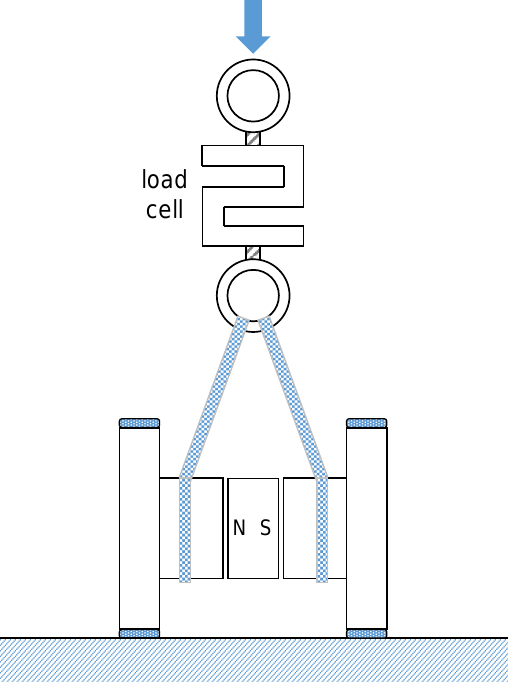
Figure 7. Sketch of a test rig. A set of ropes connect a wheel pair to a load cell. The other end of the load cell is connected to a crane that lifts up the load